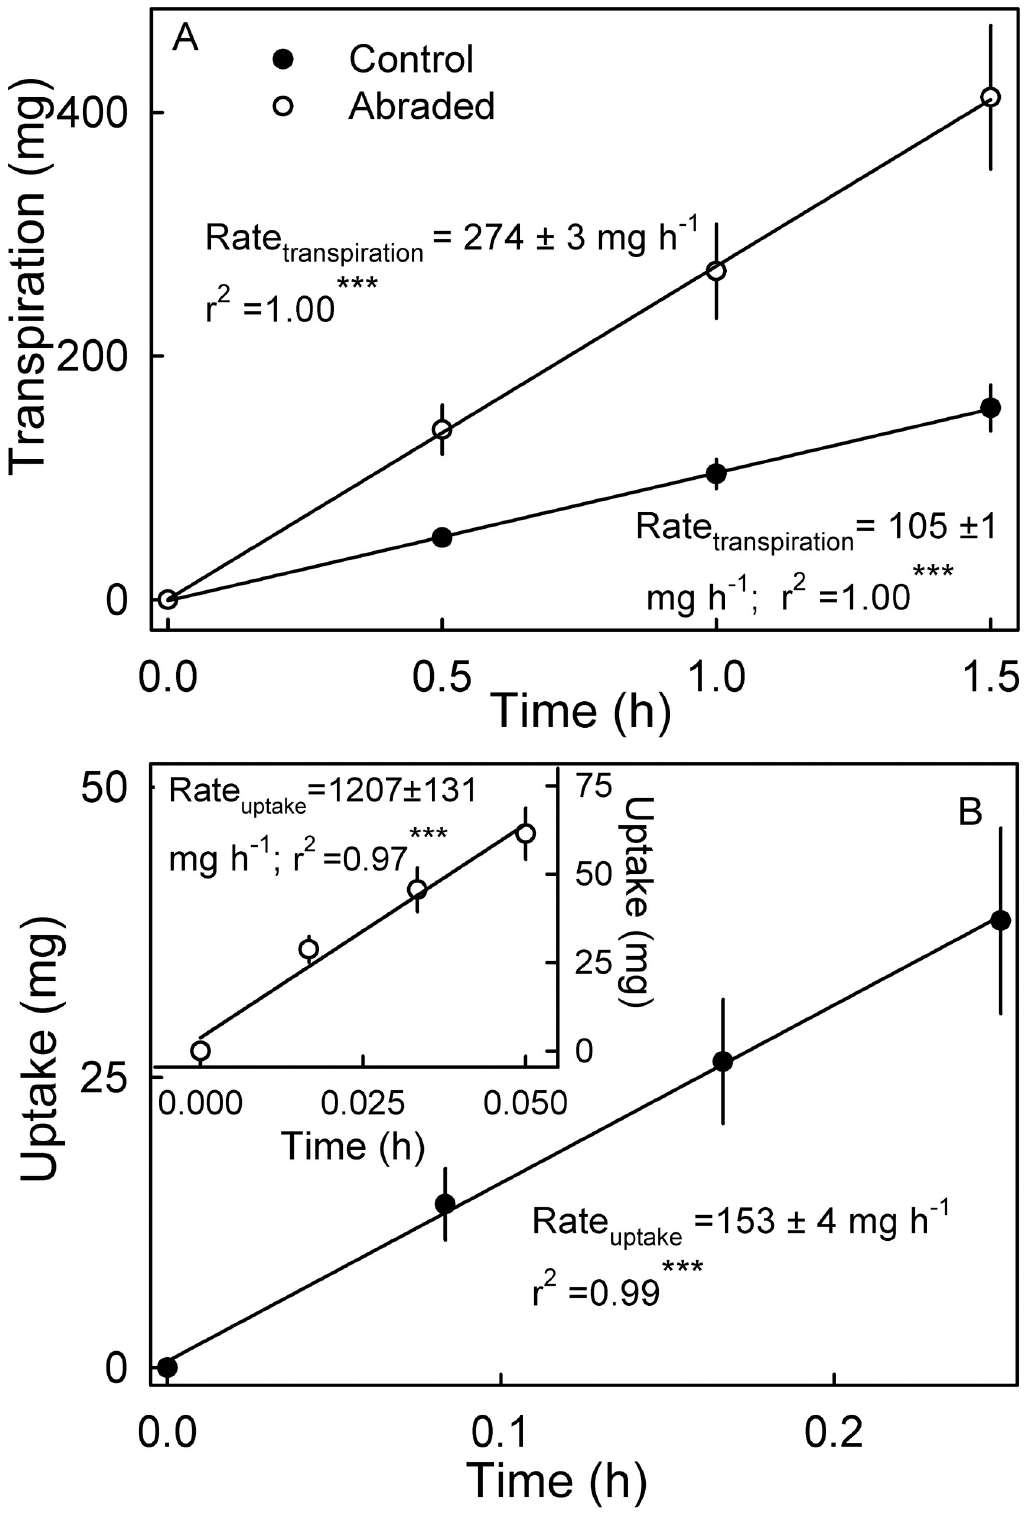
Fig 1. Effect of abrading the cuticle on water movement. (A) Transpiration and (B) osmotic water uptake. Significance of coefficients of determination (r 2 ) at P < 0.001 indicated by ��� .